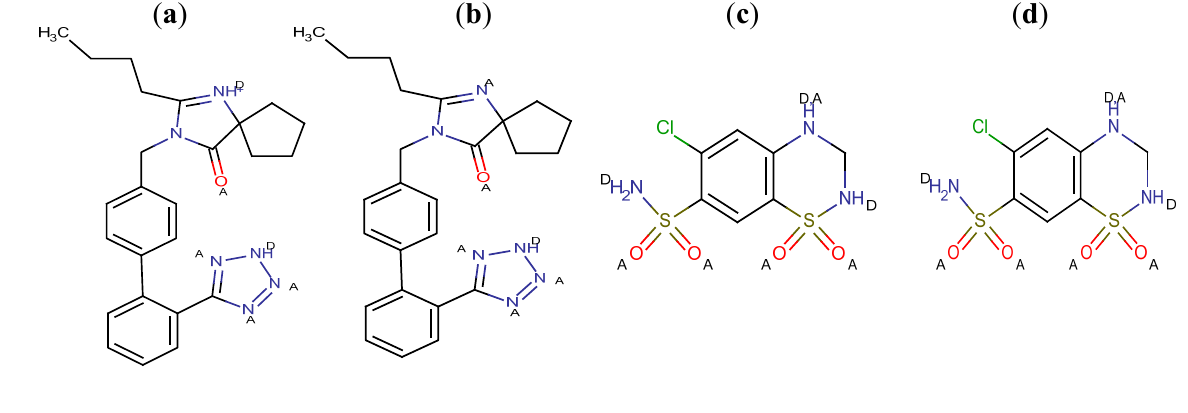
Figure 3. Structural formulae of ionized IRB.